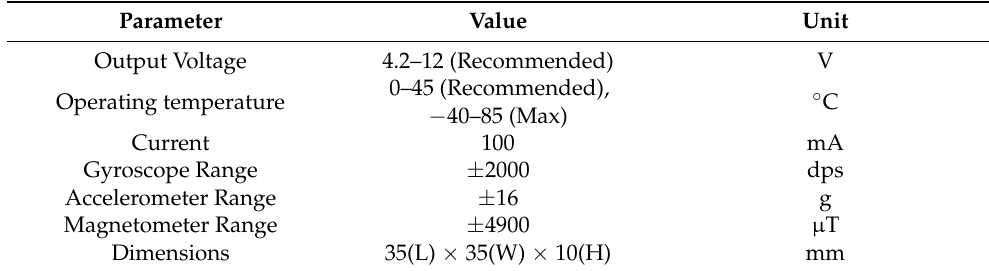
Table 3. Specifications of iAHRS-RB-SDA-v1.